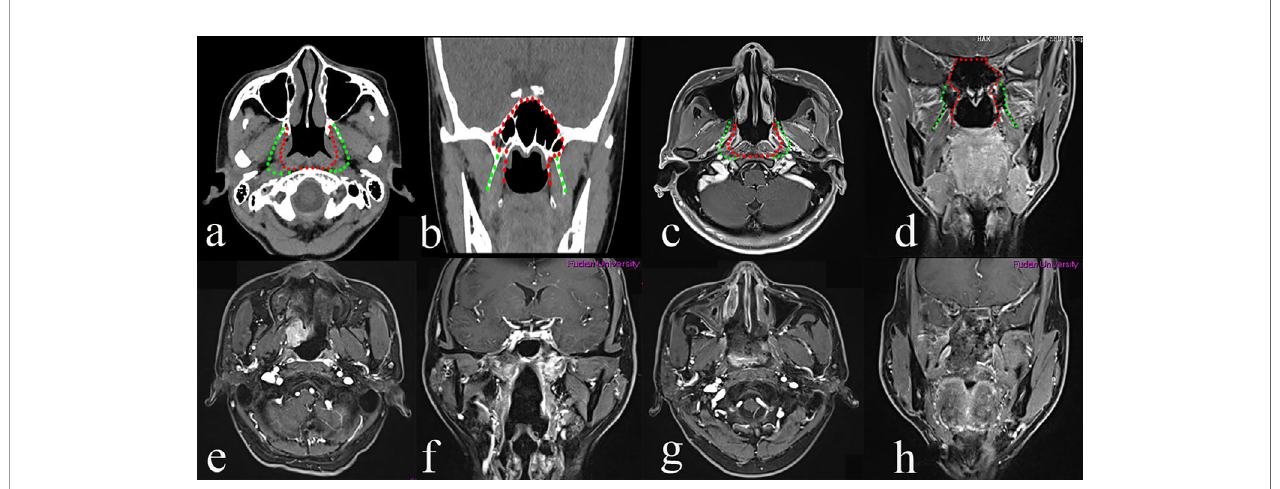
FIGURE 2 | The greatest extent of resection in Type II transnasal endoscopic nasopharyngectomy (TEN) [green dot line in (a – d) ], pre-operative magnetic resonance imaging (MRI) of rT2 nasopharyngeal carcinoma (NPC) (e, f) , and post-operative MRI (g, h) .